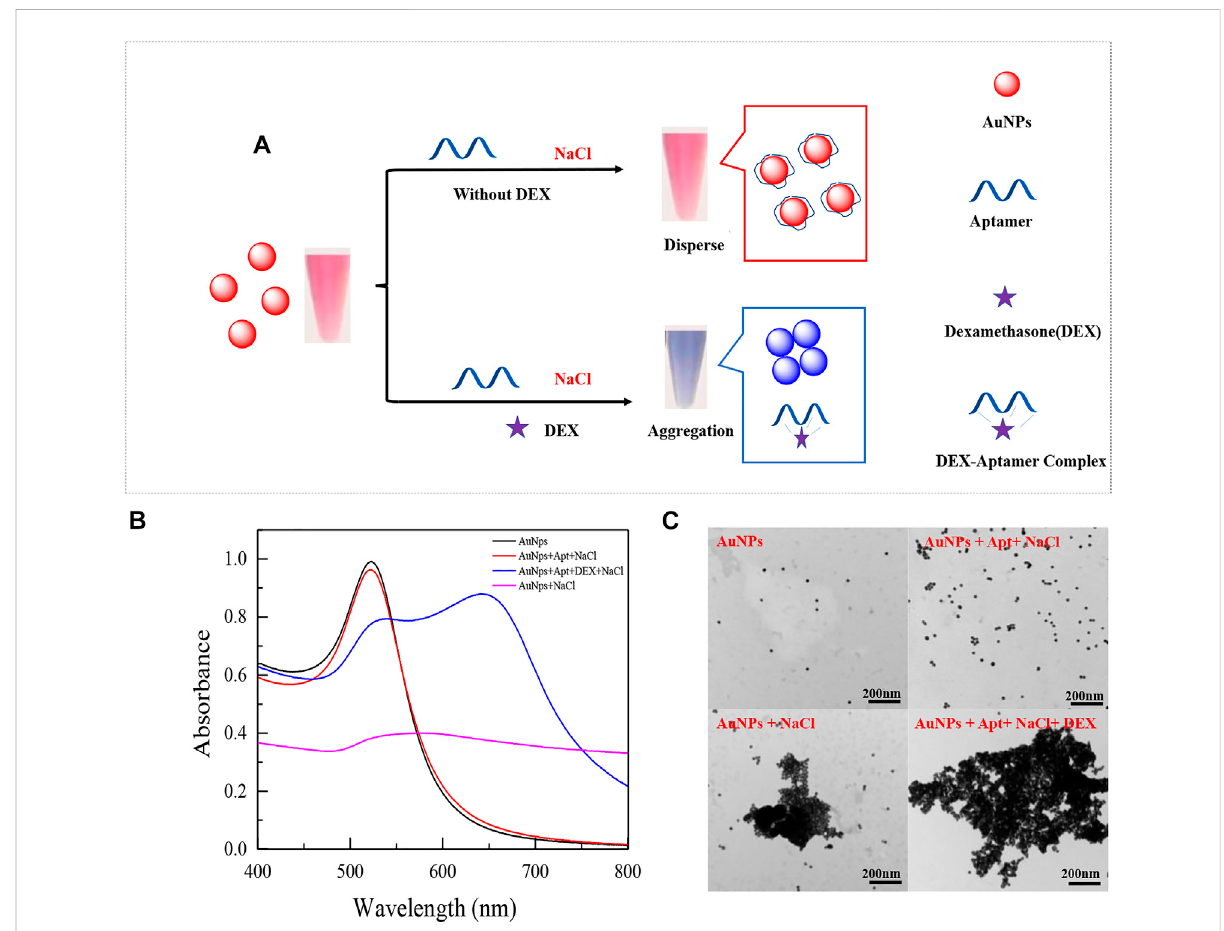
FIGURE 1 Schematic diagram of an aptamer-based colorimetric sensor (A) . UV absorption spectra of prepared AuNPs mixed with different solutions (B) , the UV spectrum shown is: (black line) 300 μ L AuNPs (13 nm) only; (red line) 300 μ L AuNPs (13 nm) + 200 μ L 0.07 μ M aptamer +200 μ L 36.7